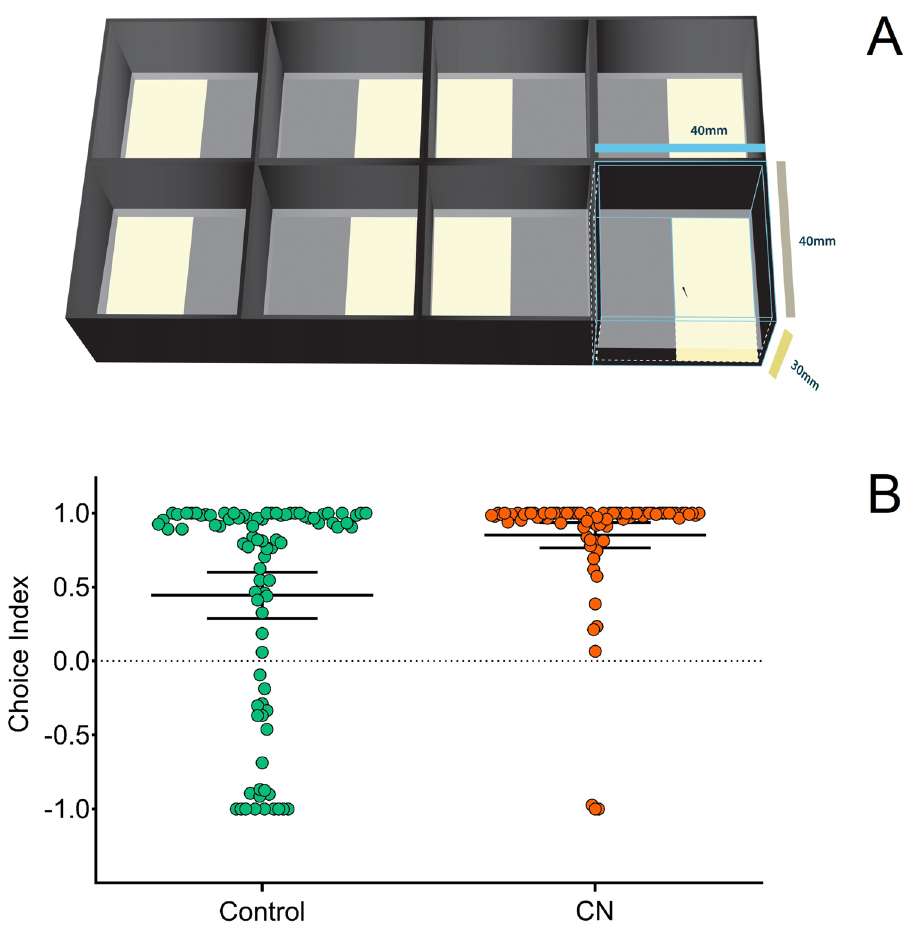
Figure 4. ( A ) Light/dark preference assay consisting of squared plastic compartments (each 40 mm width × 40 mm length × 30 mm height) divided into two equal sized areas with distinct bottom illumination (transparent/bright versus opaque/dark). The apparatus was placed on top of a LED panel (~ 7000 lx). Each compartment was filled with 10 ml water and a single larval zebrafish (5 dpf) was placed in the middle of the arena and recorded for 5 min. ( B ) Choice index for larva exposed to continuous noise (150 dB re 1 μPa) versus control conditions (U (2, 173) = 5341.50, p < 0.001). Choice index was calculated as: (Time in dark–Time in light)/(Time in dark + Time in light). Individual data are presented as scatter plots and bars depict mean ± 95% confidence intervals. Illustration was created using Adobe Illustrator CC 2020 version 24.0.2 for Windows, Adobe Inc., CA, USA and Blender version 2.80 for Windows, Blender Foundation, AMS,